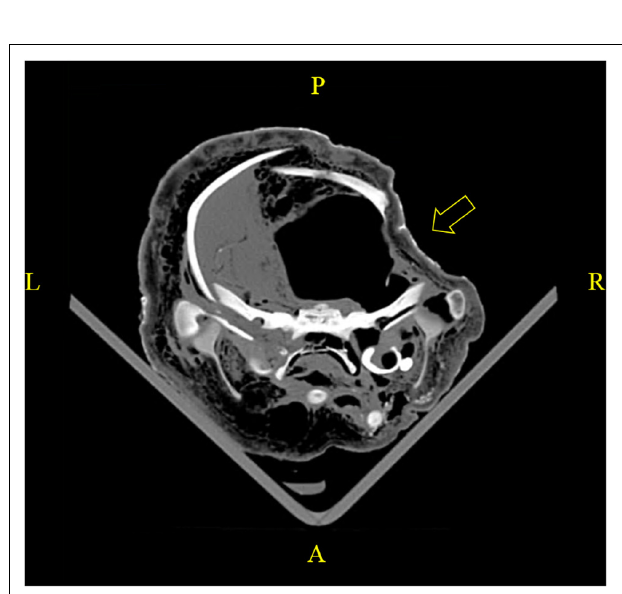
FIGURE 4 | A PMCT revealed improper storage of a carcass in a packed freezer posing undesirable PM alterations. PM cranial deformity was caused by misplacing a heavy object over the fronto-parietal region. No sign of recent bone remodeling and absence of haematoma in the adjacent soft tissue were observed, which proved the indentation was PM. Slanted level of liquefied brain indicated the carcass was frozen with a left lateral